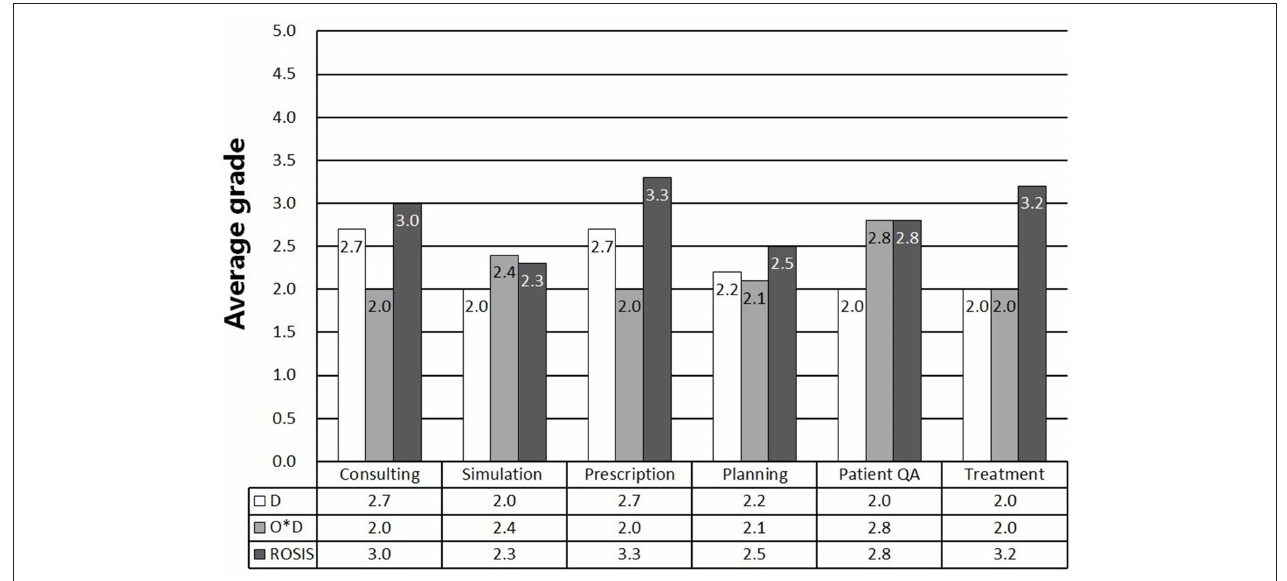
FIGURE 4 | Demonstration of the average D values of the expert group scoring and ROSIS results according to the radiotherapy